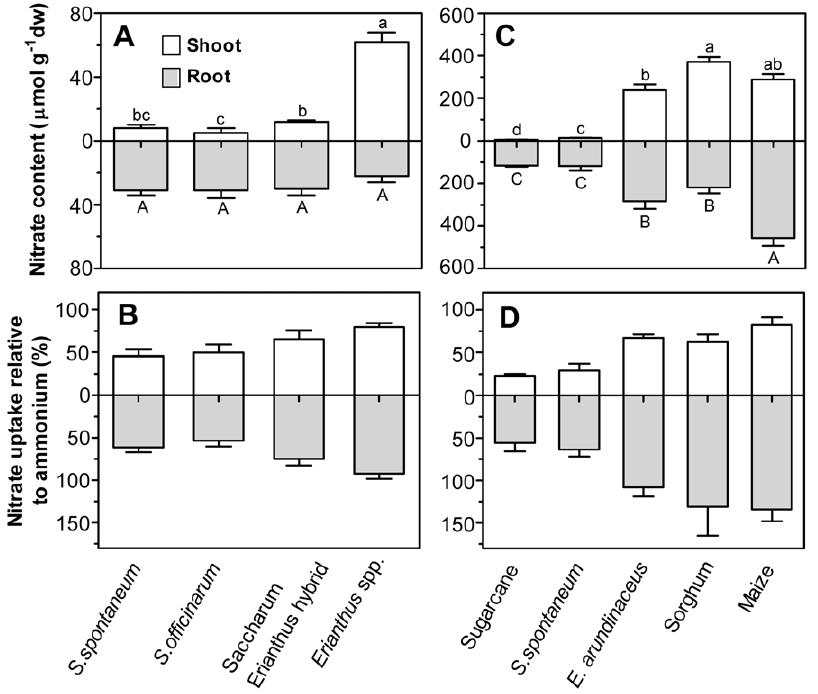
Figure 4 Nitrate use across Andropogoneae supertribe. ( A ) Shoot and root nitrate content ( m mol g 2 1 dw) of Saccharum spontaneum cultivars, S. officinarum cultivars, Saccharum-Erianthus hybrids and Erianthus species grown for 12 weeks in perlite growth medium with adequate N supplied as equimolar NH 4 + , NO 3 2 , Gly and ( B ) relative 15 N content of shoot and root of the same plants supplied with NH 415 NO 3 Gly compared to those supplied with 15 NH 4 NO 3 Gly for 24 h. Values for 3 cultivars (n=4) were pooled for each group. ( C ) Shoot and root nitrate content ( m mol g 2 1 dw) of sugarcane, S. spontaneum, Erianthus arundinaceus , sorghum and maize grown for 5 weeks in soil with adequate N supplied as equimolar NH 4 NO 3 and ( D ) relative 15 N content of shoot and root of the same plants supplied with NH 415 NO 3 compared to those supplied with 15 NH 4 NO 3 for 2 h. ( A, C ) Bars represent averages 6 standard error (n=8). A,a indicate significance difference between genotypes P , 0.05 (ANOVA, Tukey’s post hoc test). ( B, D) Values are the ratio averaged from comparisons within each of the 4 replicates, with standard error.